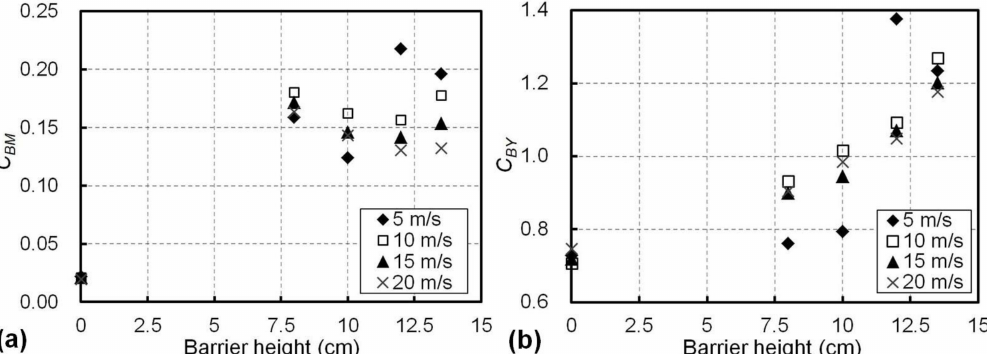
Figure 9. Aerodynamic responses of the bridge with di ff erent barrier heights at di ff erent airflow speeds for ( a ) the overturning-moment coe ffi cient, C BM , and ( b ) the side-force coe ffi cient, C BY .